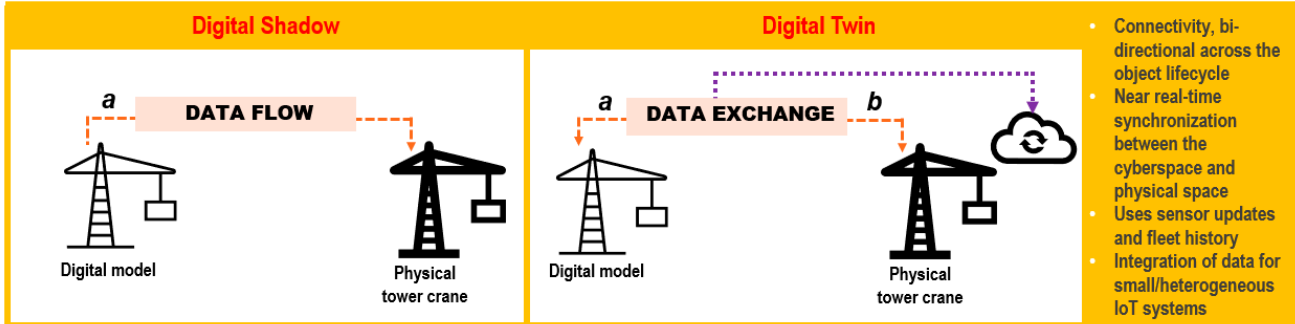
Figure 6. Schematic visualization of both ‘one-way’ and ‘bi-directional’ data flow for distinguishing DS from DT.